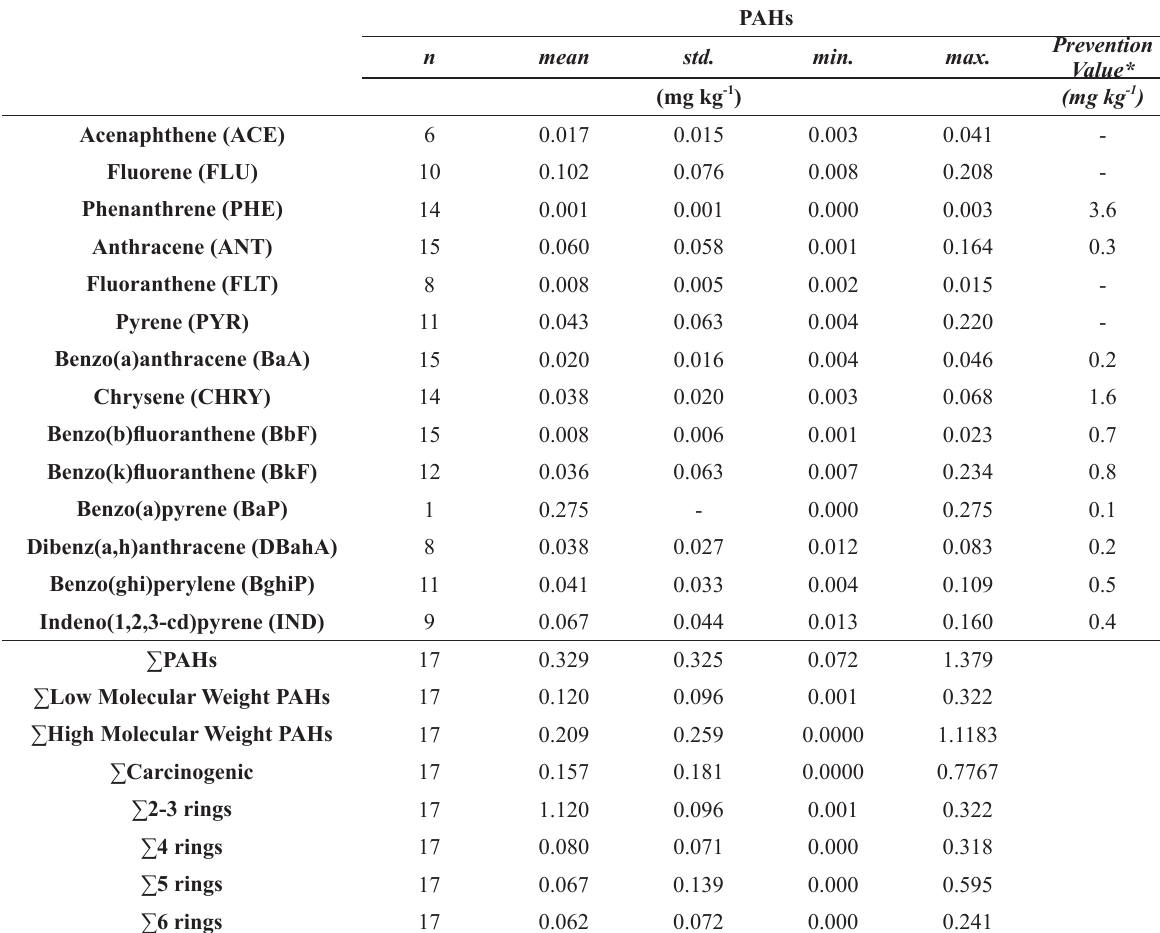
Statistics for PAHs concentration in topsoil samples from USP campus in the São Paulo city (min. - minimum; max.- maximum; std. - standard